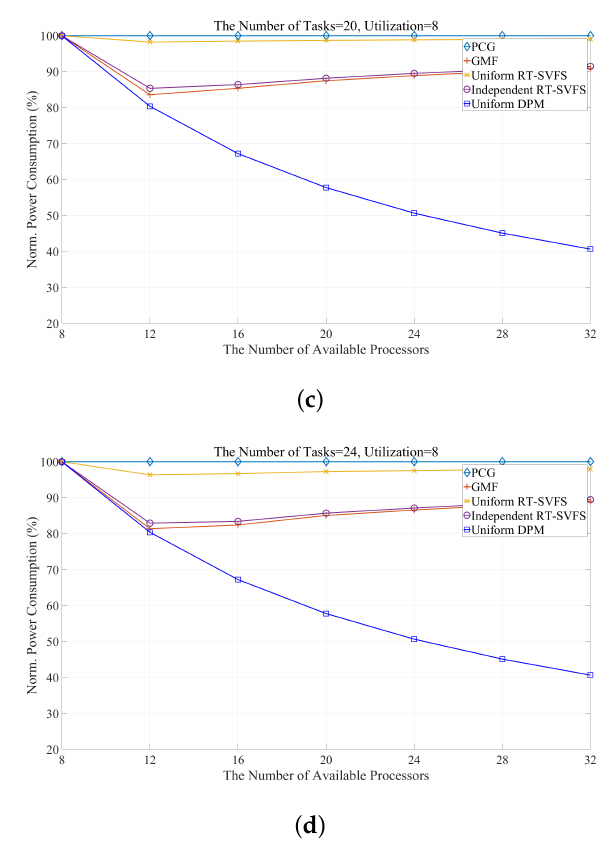
Figure 6. Comparing the energy consumption of an energy-efficient approach while varying the number of tasks: ( a ) 12; ( b ) 16; ( c ) 20; and ( d )